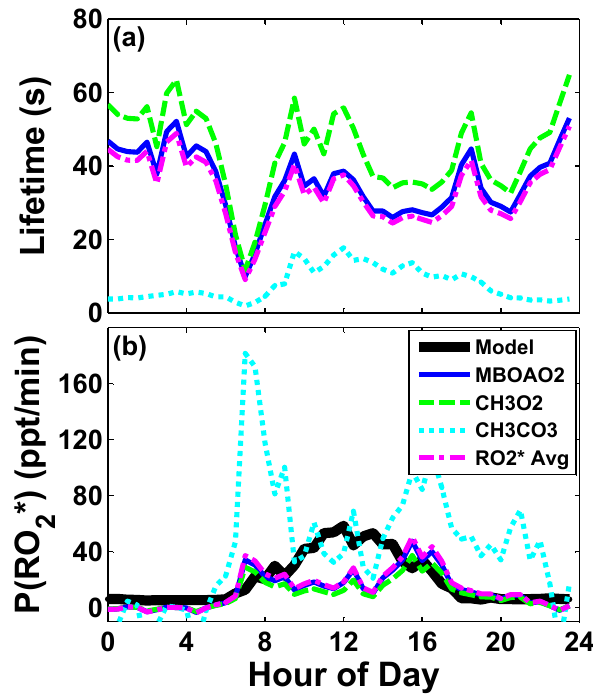
Fig. 9. (a) Modeled chemical lifetimes for several representative species: MBOAO2 (solid blue line), methyl peroxy radical (dashed green line) and acetyl peroxy radical (dashed cyan line). The concentration-weighted average RO ∗ lifetime is also shown (dash- 2 dotted magenta line). (b) Missing RO ∗ production rates calculated 2 as described in the text. Also shown is the total production rate for all modeled RO 2 * (thick black line). Model results are taken from the base